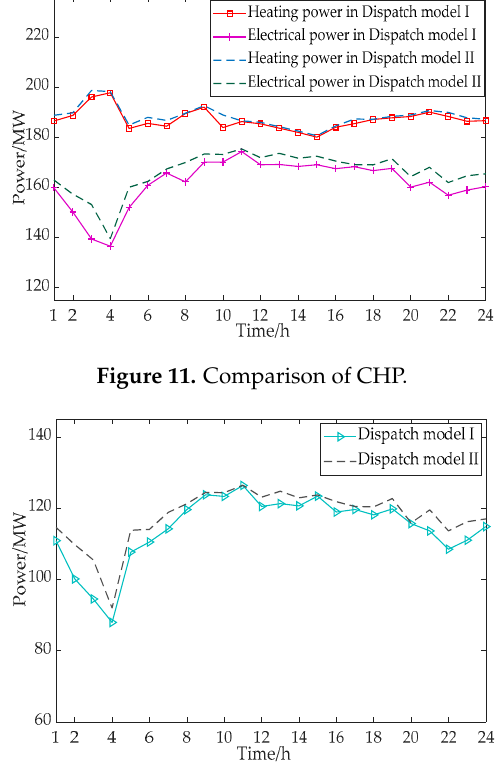
Figure 12. Comparison of thermal power unit.